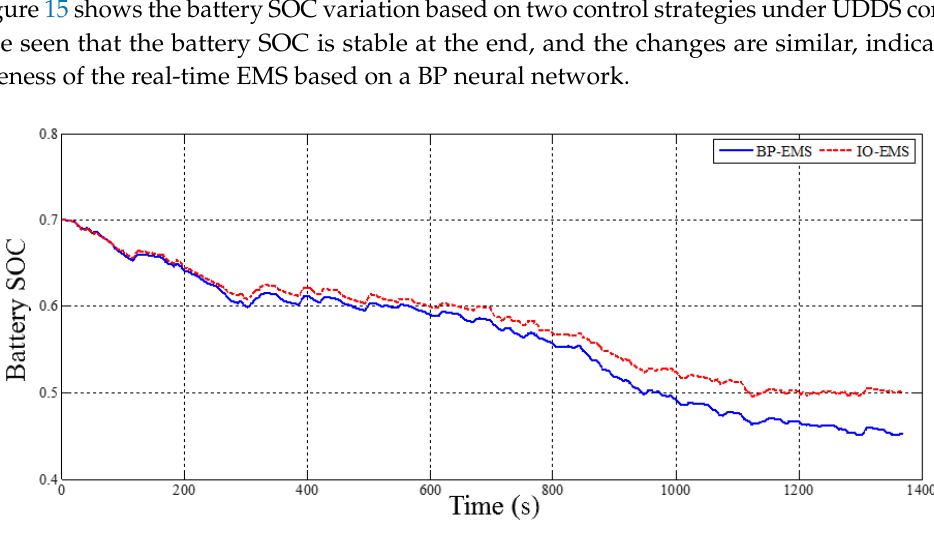
Figure 15. State of charge of battery during UDDS driving cycle.